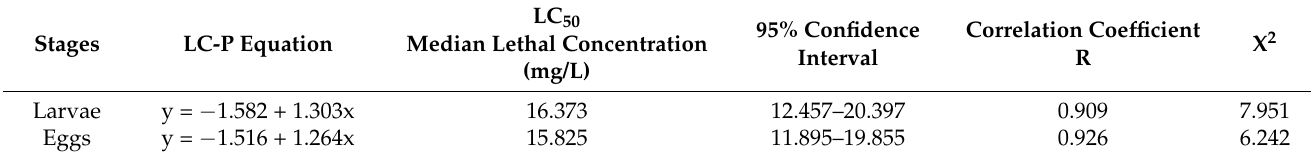
Table 2. Toxicological parameters of diflubenzuron against eggs and larvae from T. cinnabarinus . LC 50 95% Confidence Correlation Coefficient Stages LC-P Equation Median Lethal Concentration X 2 Interval R (mg/L) Larvae y = − 1.582 + 1.303x 16.373 0.909 7.951 Eggs y = − 1.516 + 1.264x